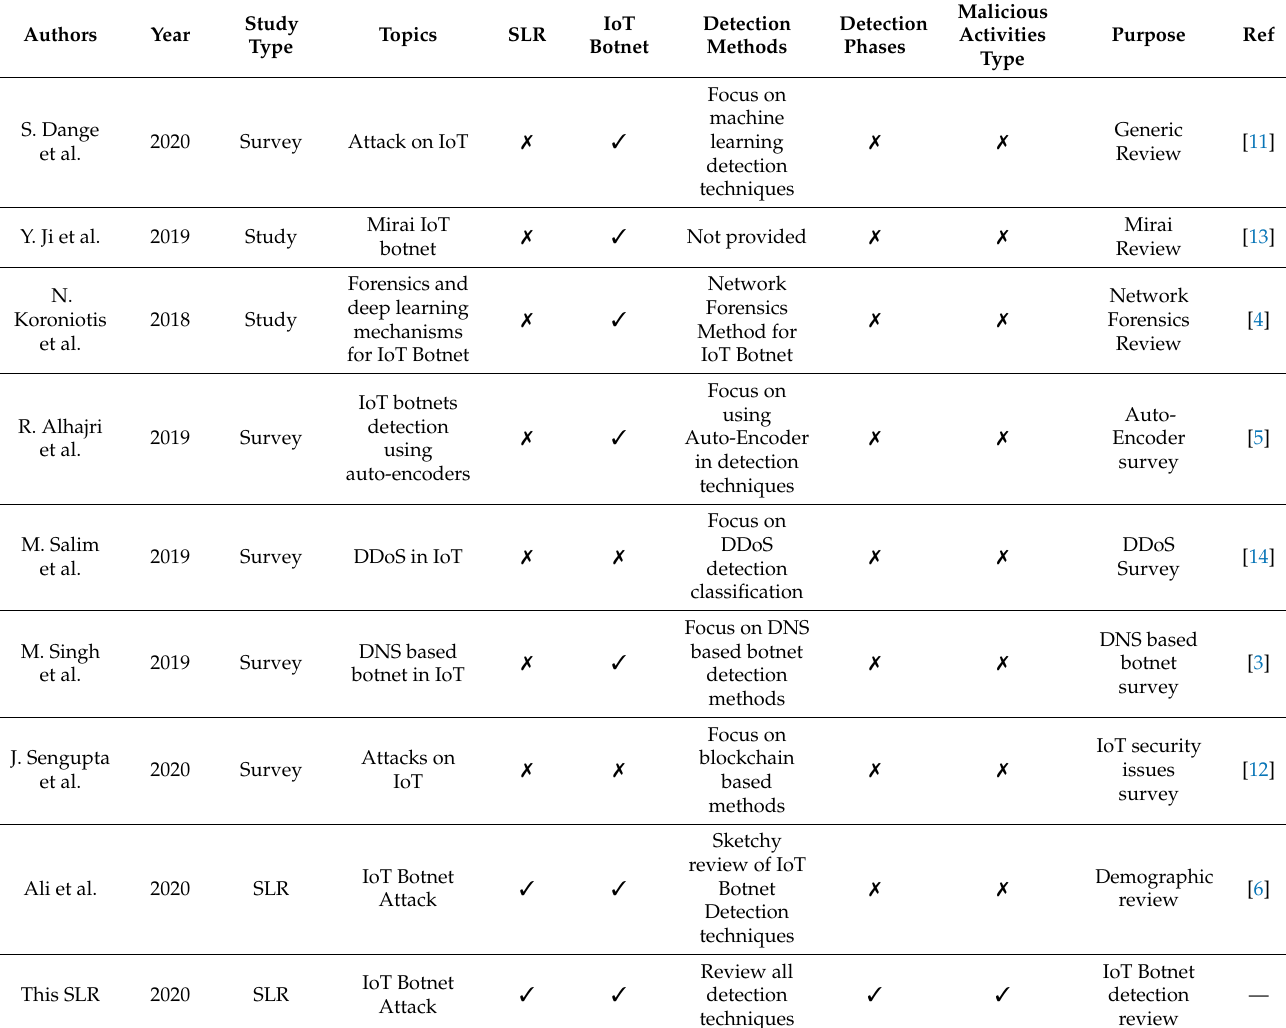
Table 1. A comparison of the related